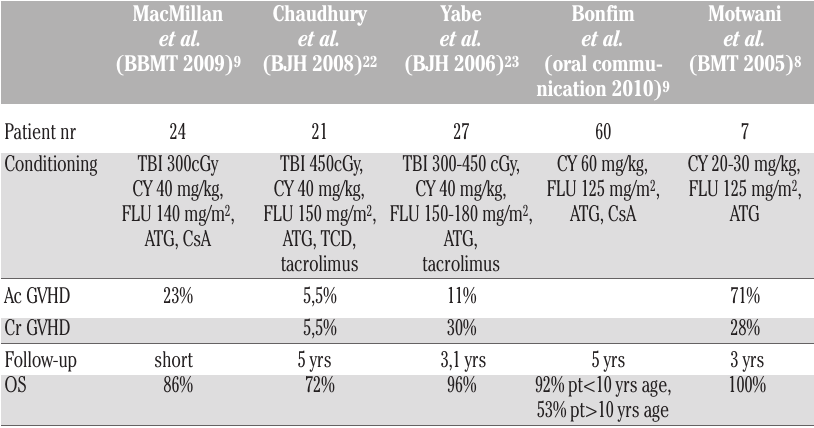
Table 2. Matched unrelated donor transplants: conditioning regimen and outcome. MacMillan Chaudhury